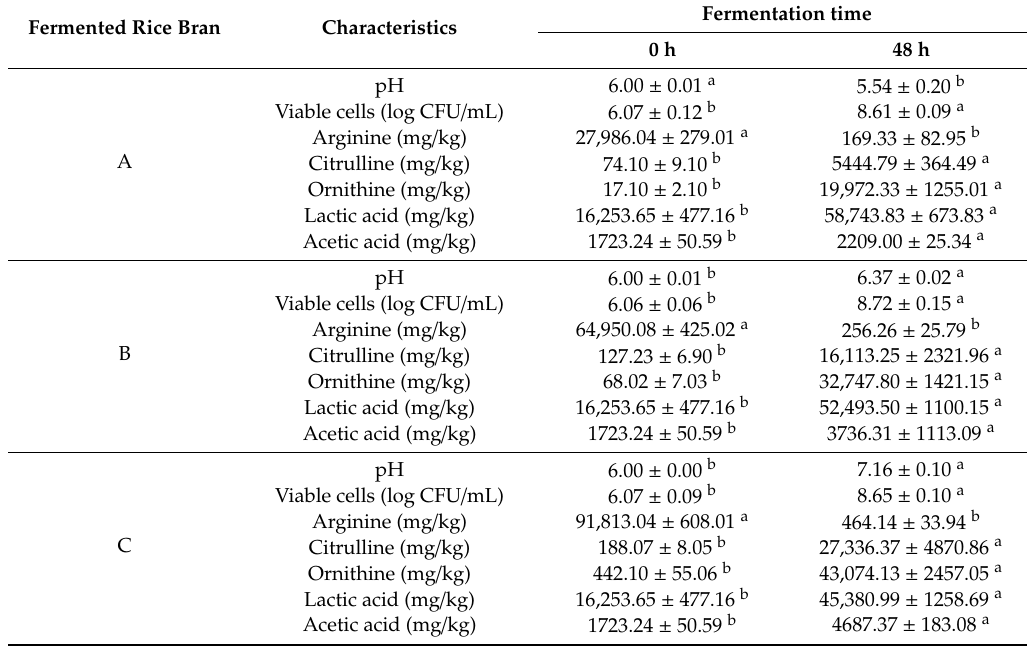
Table 4. pH, viable cell, and amino acid content changes in fermented rice